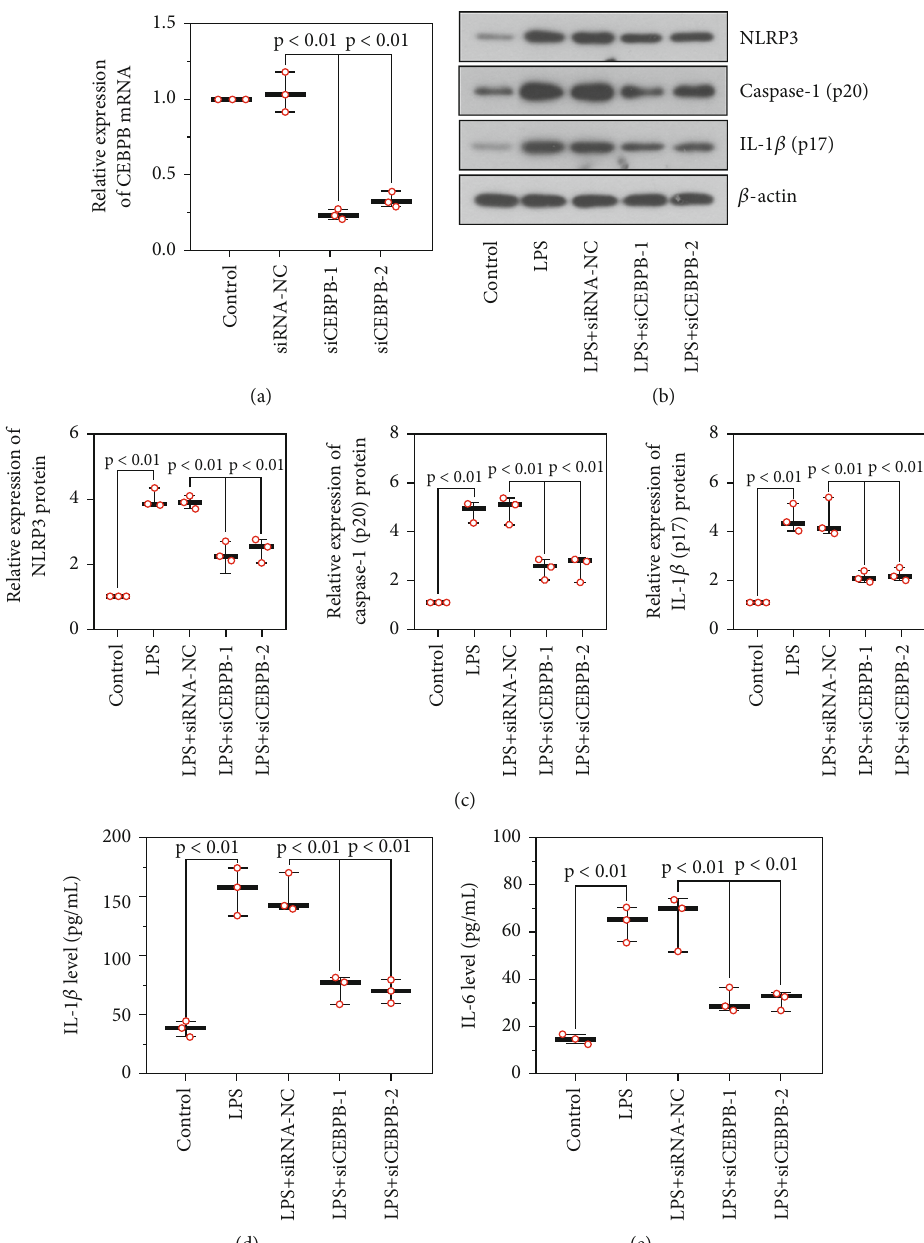
Figure 5: The knockdown of CEBPB inhibited the activation of NLRP3 in fl ammasomes in glomerular podocytes. Interference e ffi ciency of CEBPB siRNAs (a). Protein expression of in fl ammasome-related proteins in podocytes stimulated with LPS and ATP (b, c). The content of IL-1 β (d) and IL-6 (e) in the cell supernatant. (CEBPB, CCAAT/enhancer-binding protein β ; ATP, adenosine triphosphate; LPS,